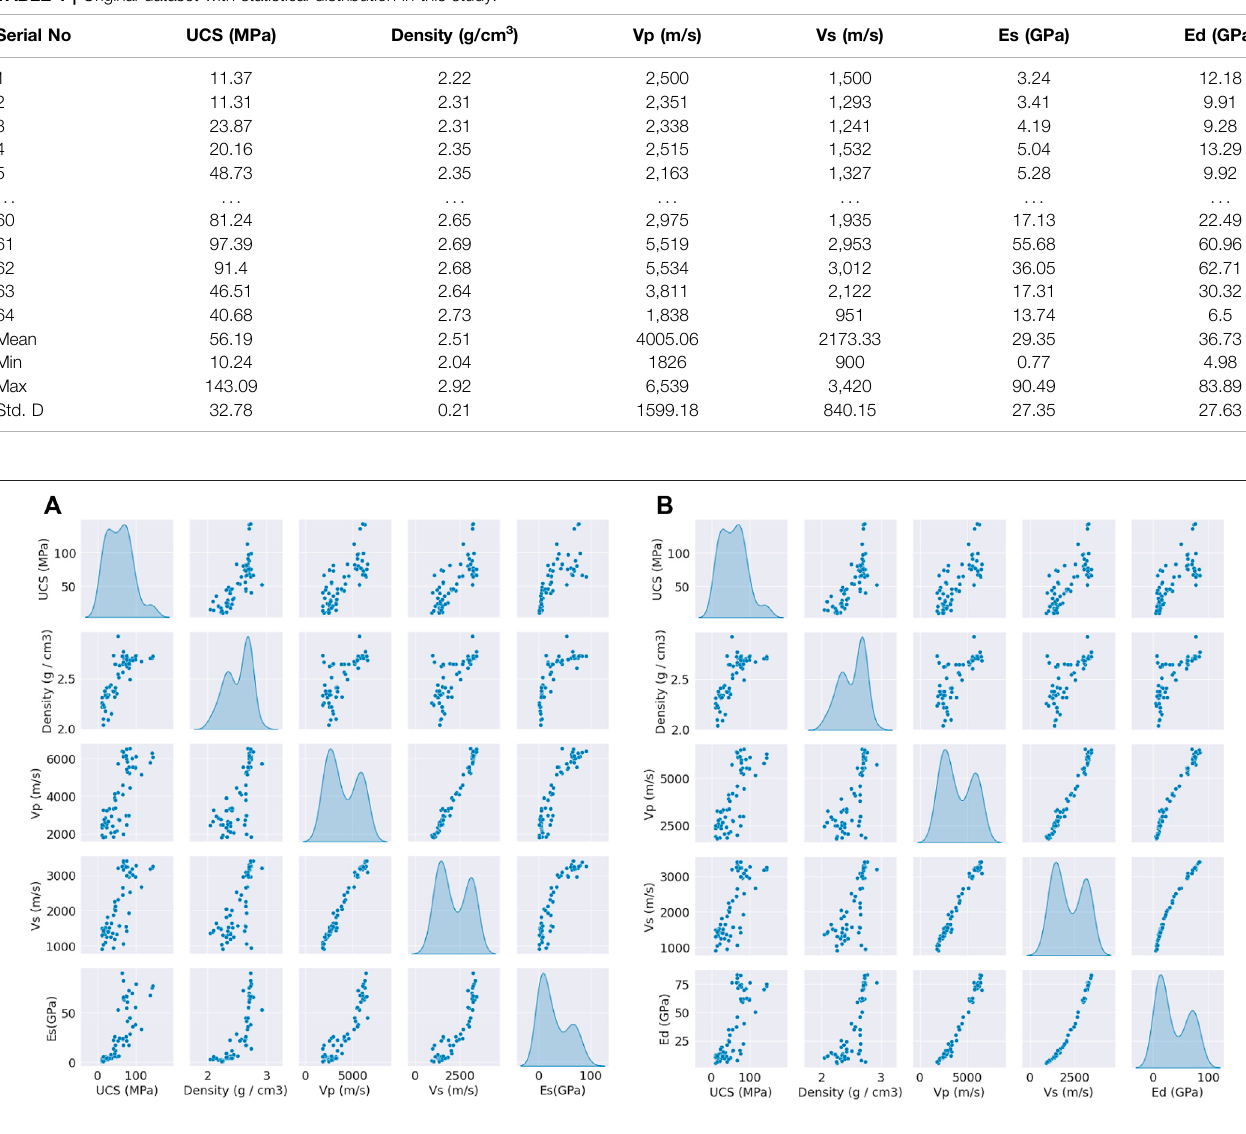
Frontiers in Earth Science |